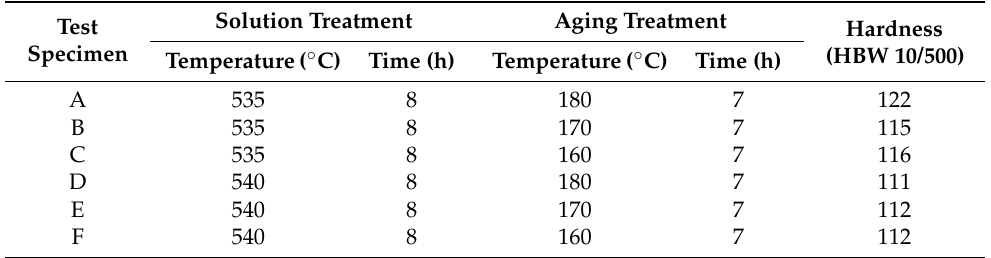
Table 7. Hardness changes due to the temperature and duration of the solution and aging treatments. Test Specimen